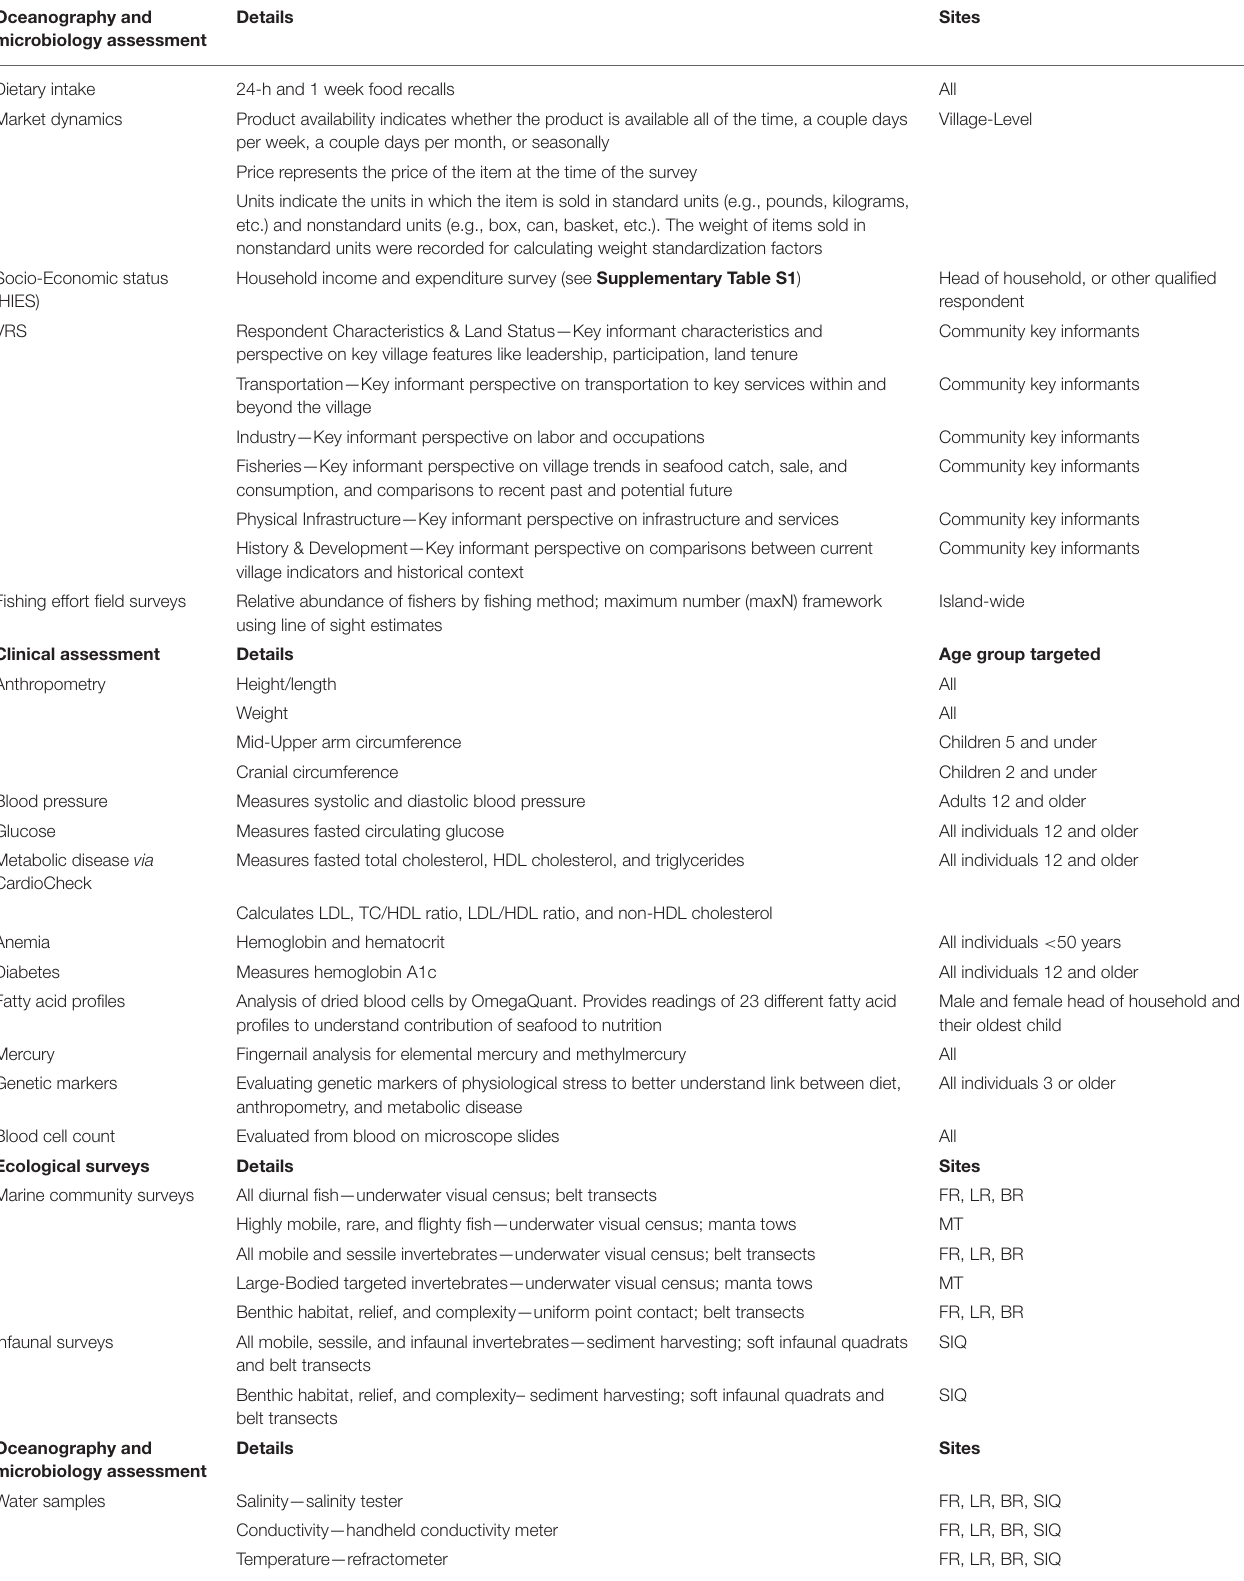
TABLE 2 | Description of all survey data and